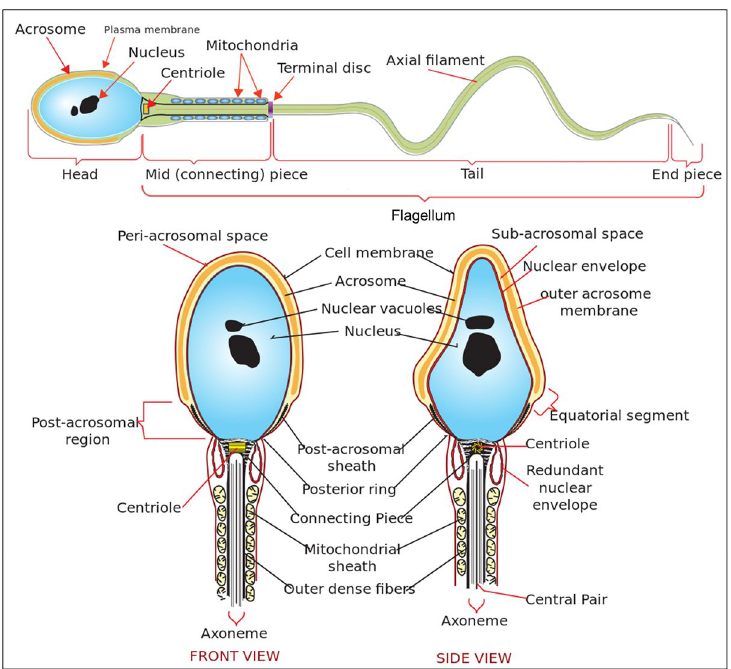
Figure 2. Diagram of a human sperm cell 36 . (Top) Main components of a sperm cell. (Bottom) Front and side view of sperm head and midpiece.